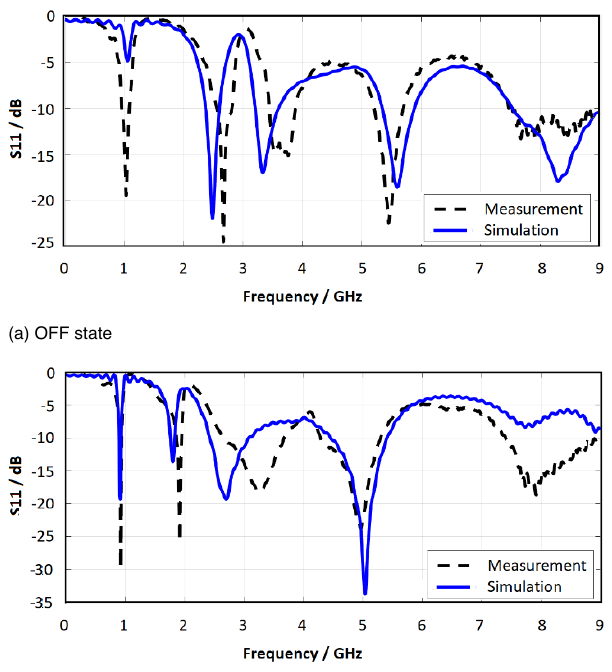
FIGURE 7. The simulated and measured reflection coefficient of the single antenna